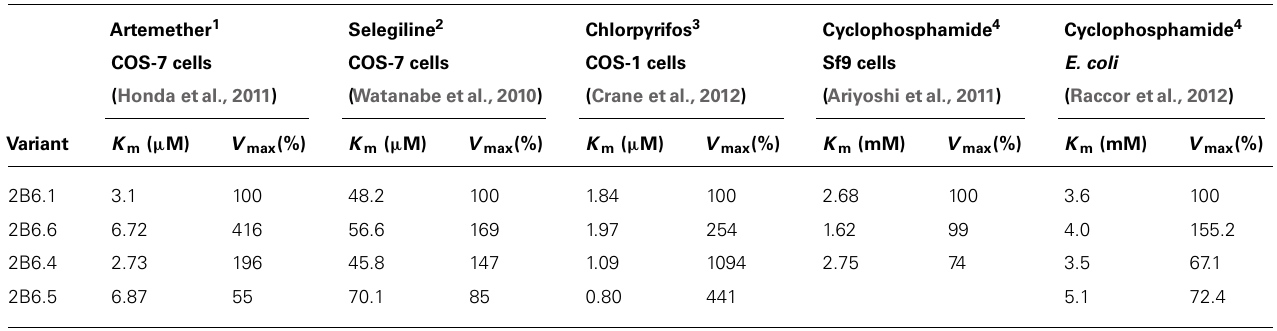
Table 3 | Properties of recombinantly expressed CYP2B6 protein variants with other clinical substrates. Artemether